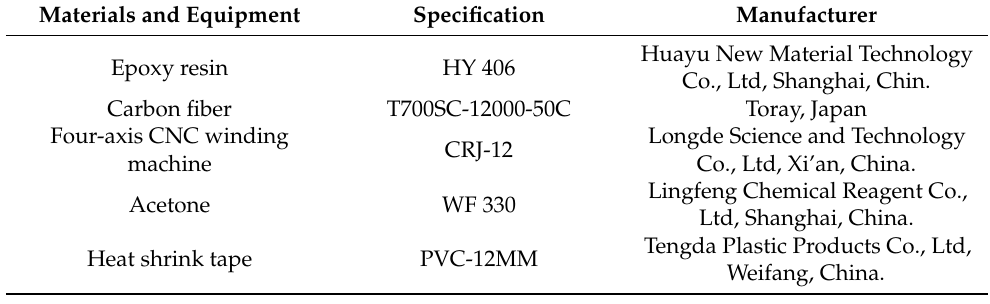
Table 3. Main experimental materials and equipment.